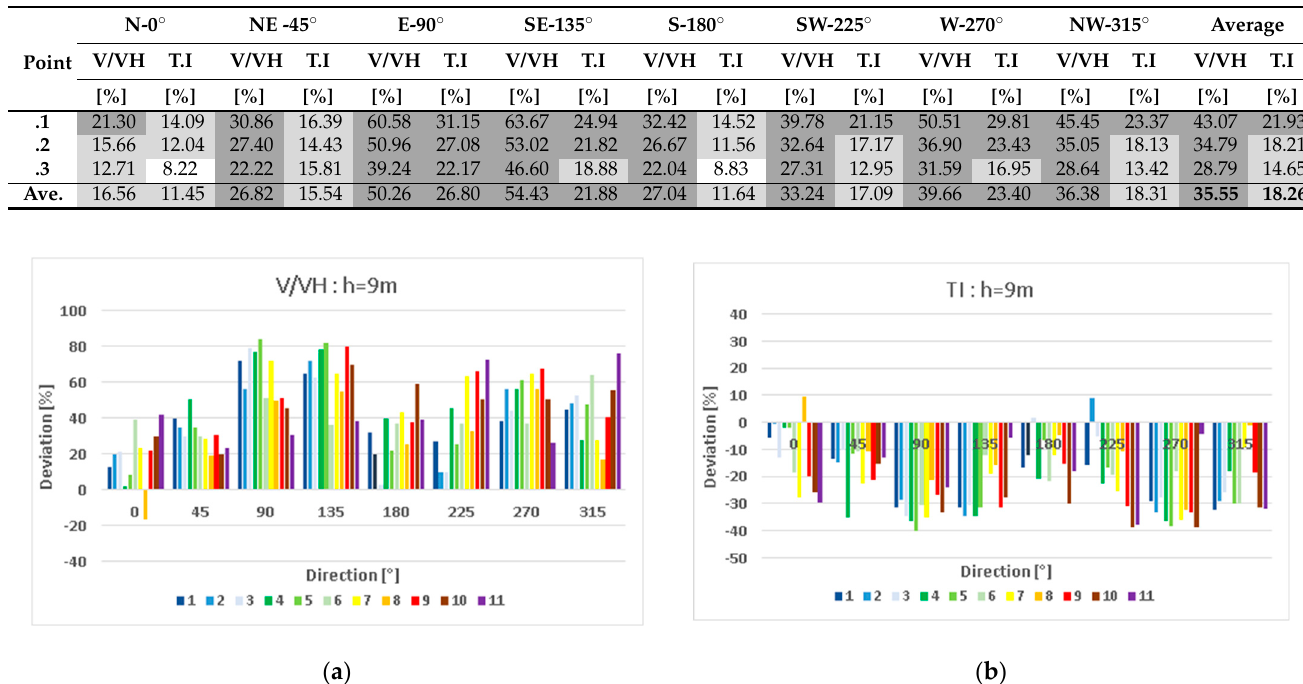
Table 6. Mean Absolute deviation results obtained from the WAsP Engineering model per height and sector. V/VH is the ratio between velocity (V) and velocity at the top of the boundary layer achieved by the model (VH); TI is the turbulence intensity. Values shadowed by dark grey represent deviations with values ≥ 20% or ≤− 20% while values shadowed by light grey color represent deviation values ≥ 10% or ≤− 10% and no shadowed values have deviation values > − 10% or values < 10%. Points denoted by .1 or .2 or .3 mean height above ground at 9 m, 12 m, and 17 m, respectively.